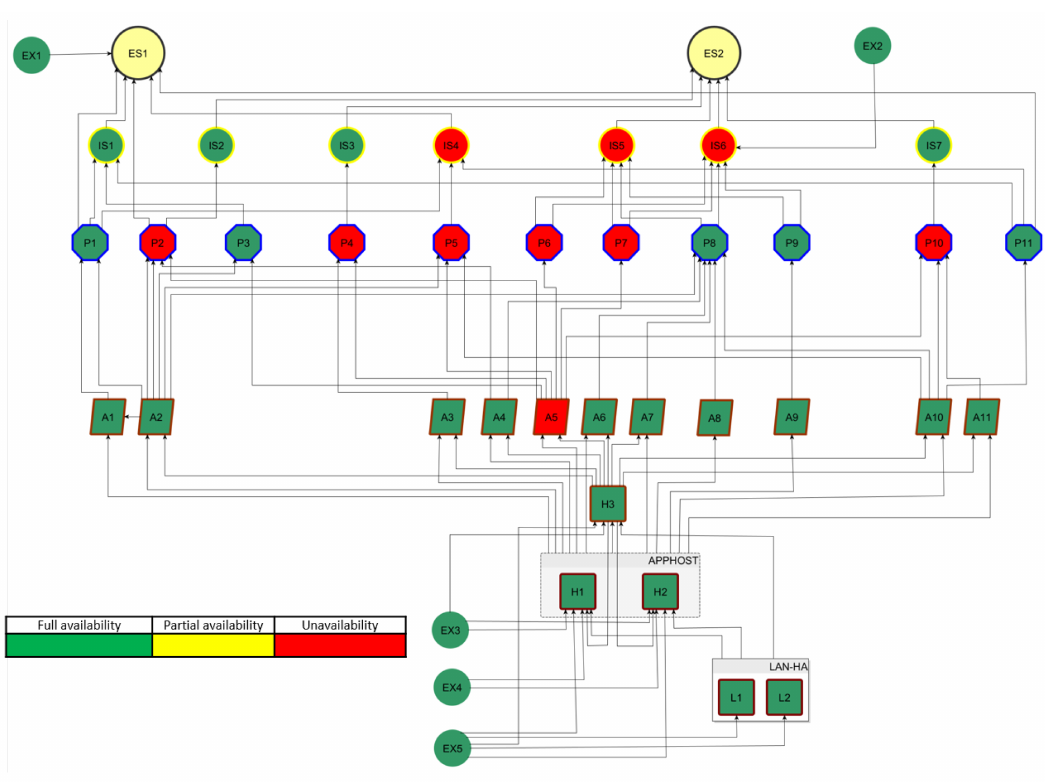
Figure 10. Object availability at time t = 5